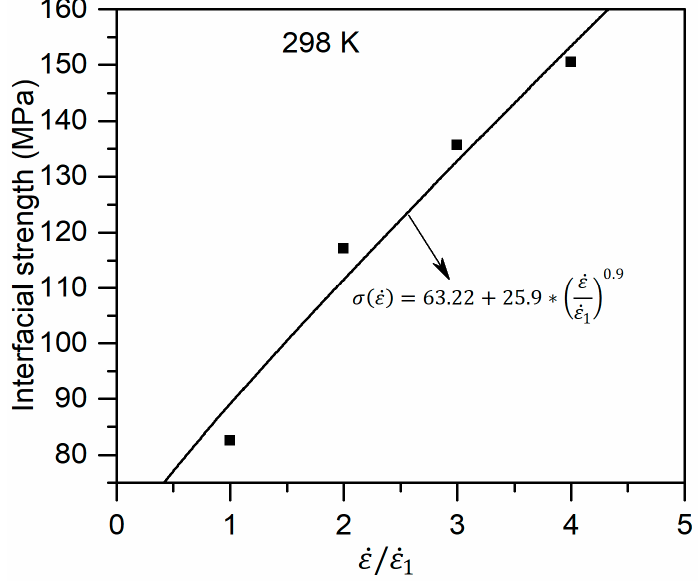
Figure 8. The interfacial strength as a function of strain rate.